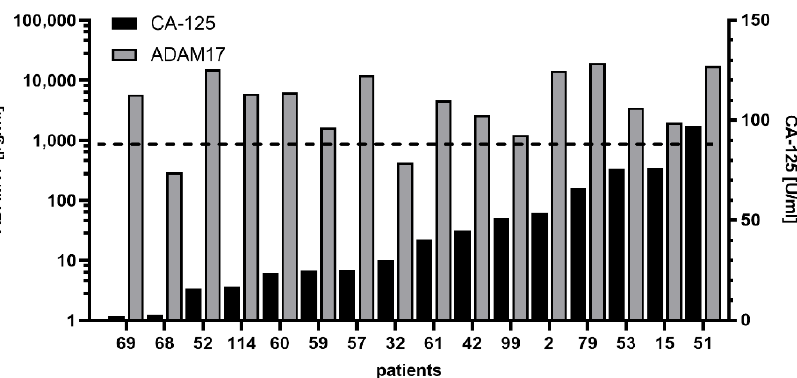
Figure 6. ADAM17 levels in patients with low CA-125. Each number represents a patient from the patient cohort. Descriptive bar chart showing ADAM17 level (white bars) in patients with low CA-125 (<100 units/mL, grey bars). Ordered from low to high CA-125 amounts. The dashed horizontal line indicates 75th percentile of control